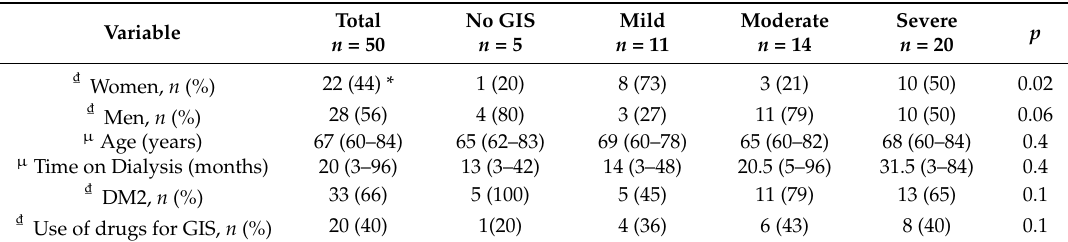
Figure 1. Flowchart of the study selection process. HD, hemodialysis; PD, peritoneal dialysis. Characteristics of the study population are shown in Table 1. The prevalence of type 2 diabetes mellitus (DM2) corresponds to 66% of the total patients: 70% in HD and 63% in PD. Of the total population, 90% reported the presence of at least one GIS. The median age of participants was 67 years. When dividing the population by age range (60 to 65 years, 66 to 74 years, and ≥ 75 years), no significant differences were found in the prevalence or severity of the GIS (with GIS scores of 13.5, 12.1, and 12.1, respectively ( p = 0.35)). Additionally, there was a difference in GIS severity only in women ( p < 0.02) but not in men ( p > 0.06), and there were no differences according to gender in regard to total GIS score between women and men ( p = 0.8), or presence of diabetes ( p = 0.1). Regarding time on dialysis, the population was divided into three groups according to time on dialysis: <1 year, from 1 to 4 years, and >4 years; we did not find differences in the score of severity of GIS according to time on dialysis ( p = 0.9). Forty percent of the patients reported the use of some drug(s) for the relief of their GIS: use of probiotics; only 8 patients (16%) reported consistent use of phosphate binders. Table 1. General characteristics of the study population by severity of GIS.